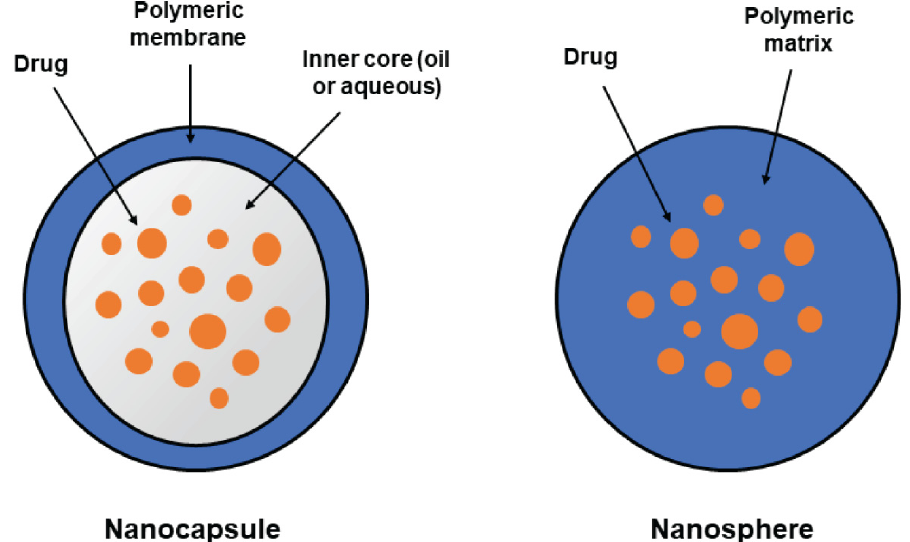
Figure 2. The two main structural forms of polymeric nanoparticles: nanospheres (matrix system) and nanocapsules (reservoir system).